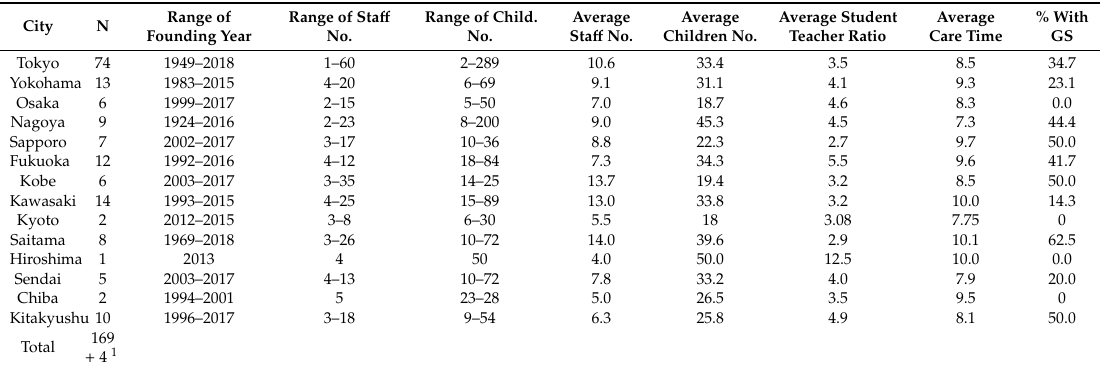
Table 3. Characteristics of surveyed unlicensed daycare